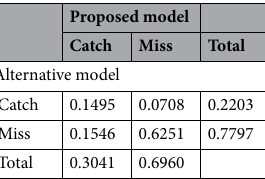
Table 9. Catch and Miss rates of top-5 recommendations of the proposed and alternative